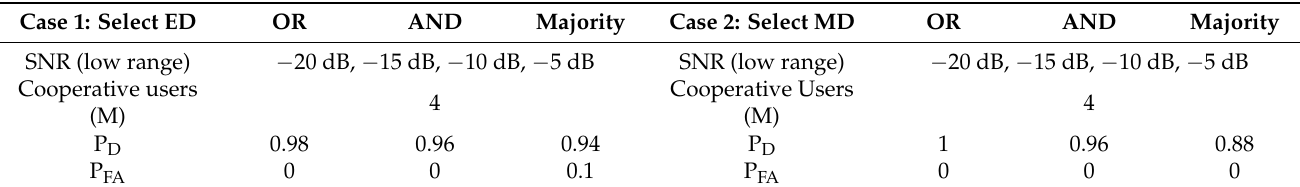
Figure 11. Hybrid detector under CSS(4): Majority for case 2. Table 3. Hybrid detector performance parameters under CSS environment .